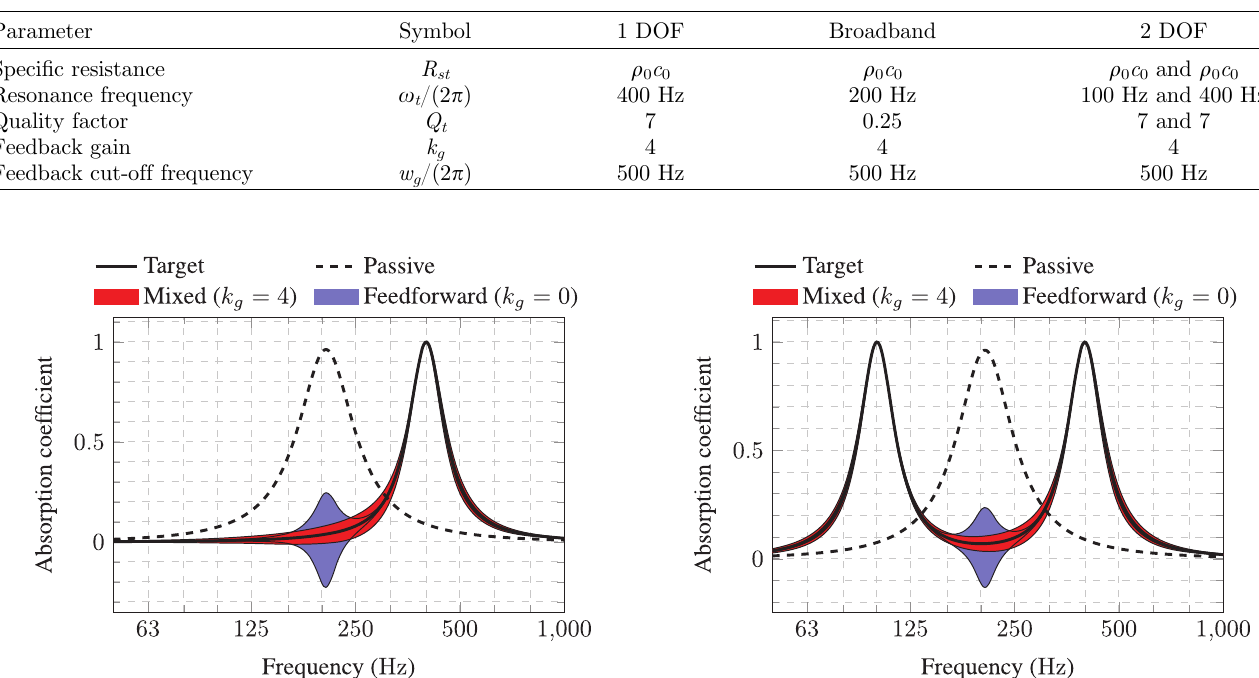
Table 1. Target impedances and control parameters for the three considered con fi